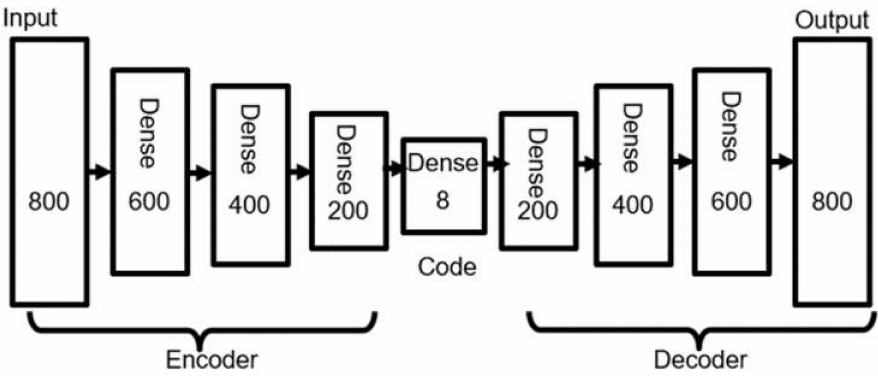
Figure 3. The autoencoder structure adopted from the FPFE